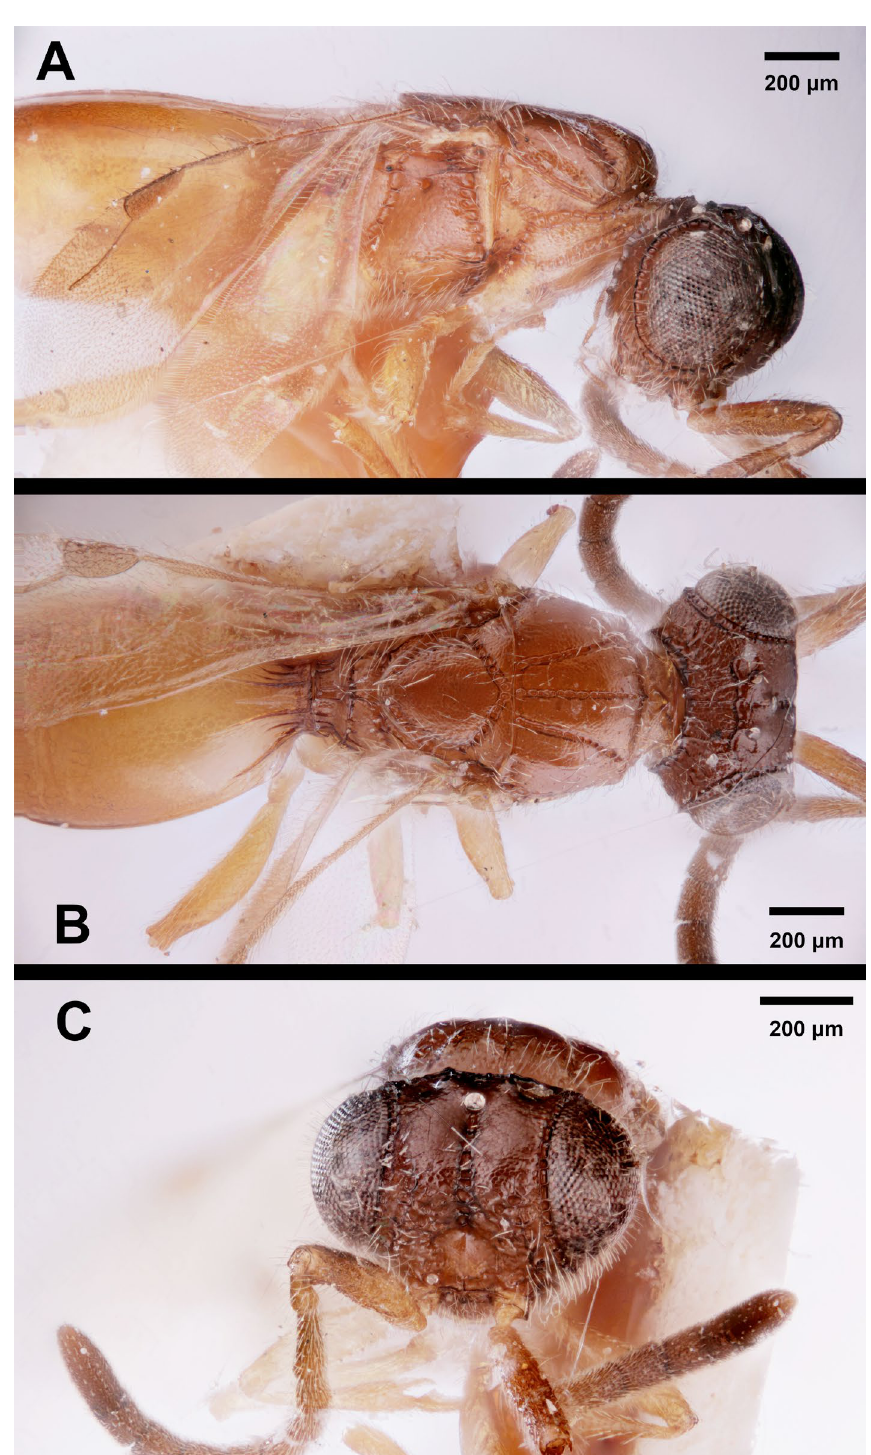
Fig. 16. Conostigmus divisifrons kieffer, 1907, synonymized with Conostigmus abdominalis (Boheman, 1832), holotype, ♀ (MNHN EY25343). A . Lateral view. B . Dorsal view. C . Frontal